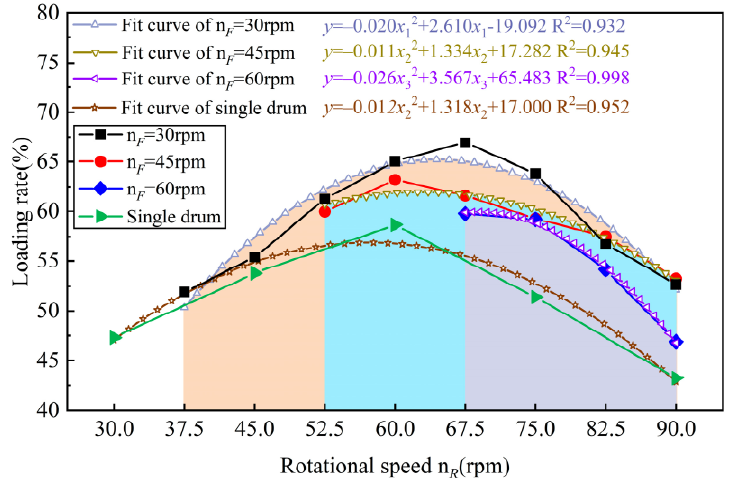
Figure 15. The loading rate of different rotational speed matching between the front and rear drum.